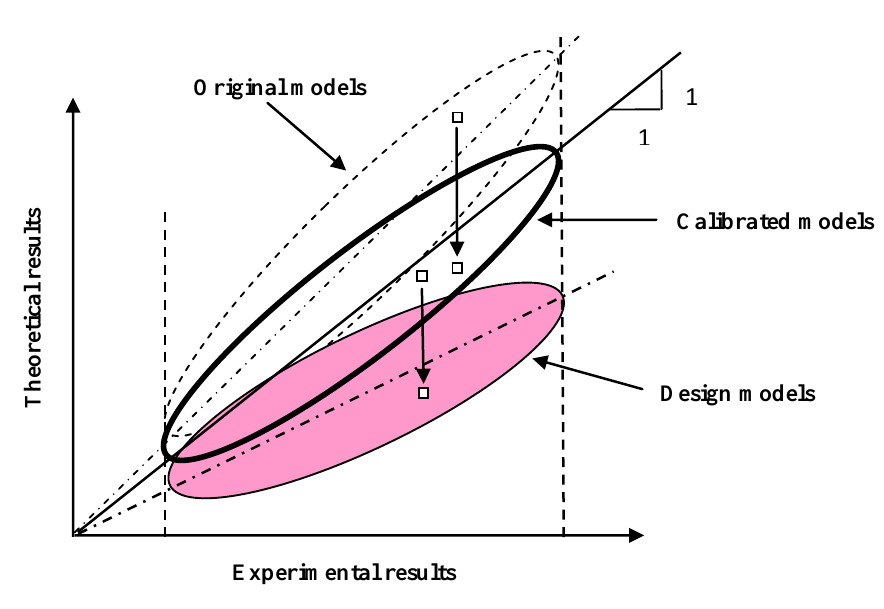
Experimental results Fig. 1. Schematic procedure of the study.